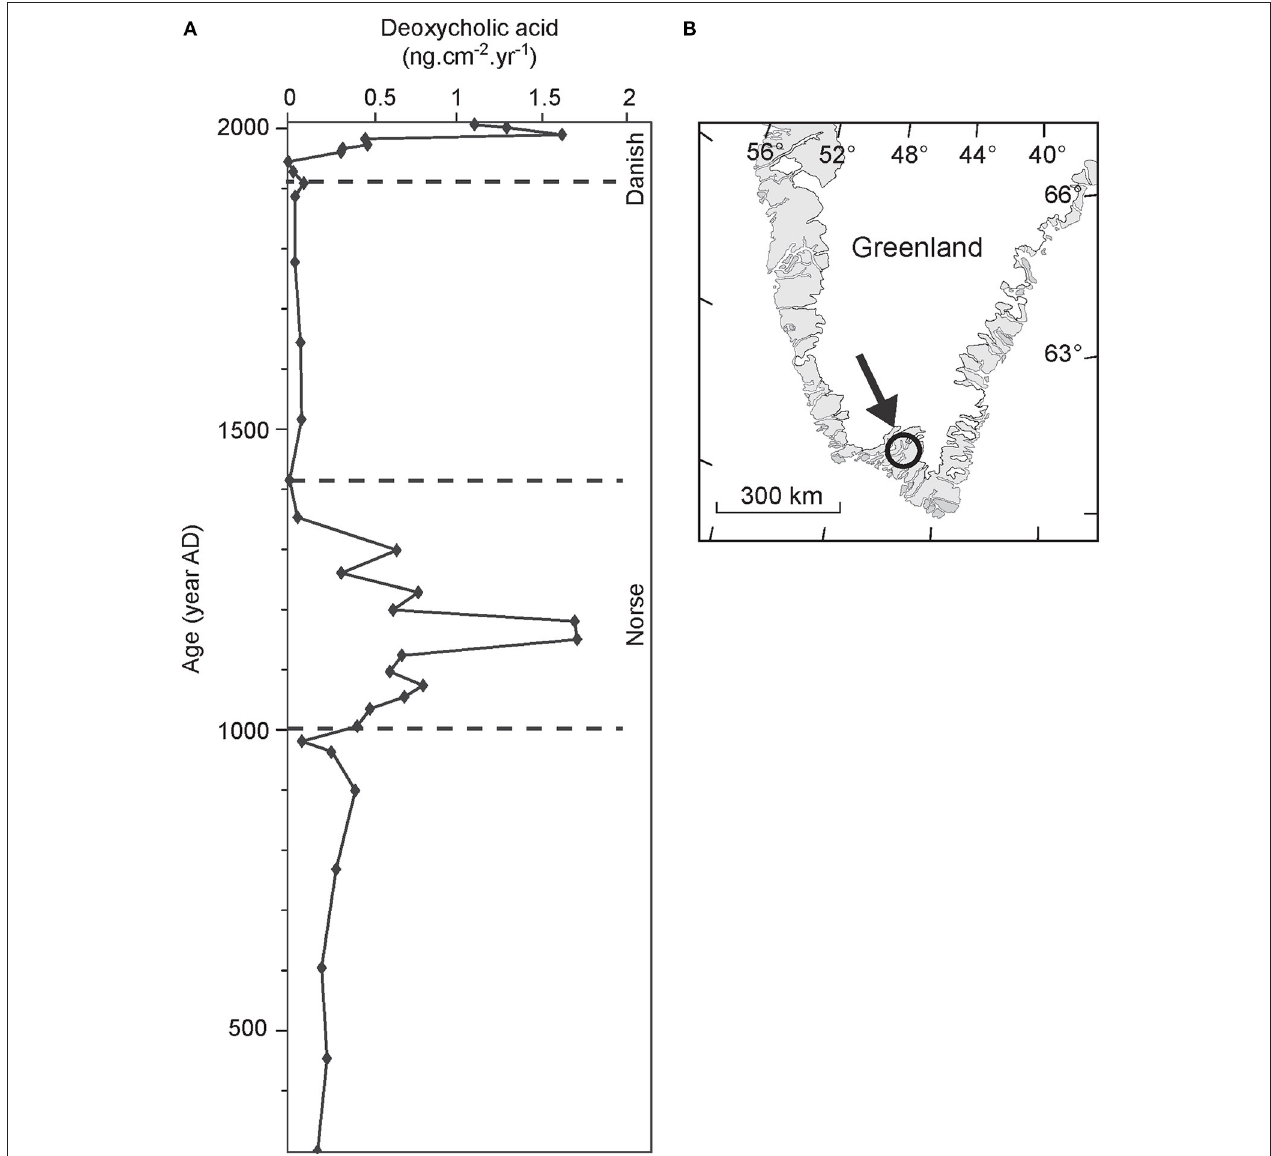
FIGURE 4 | (A) Evolution of deoxycholic acid in the sediments of Lake Igaliku in relationship with Norse and Danish colonization and breeding; (B) Location of Lake Igaliku (Greenland). Modified from Guillemot et al.